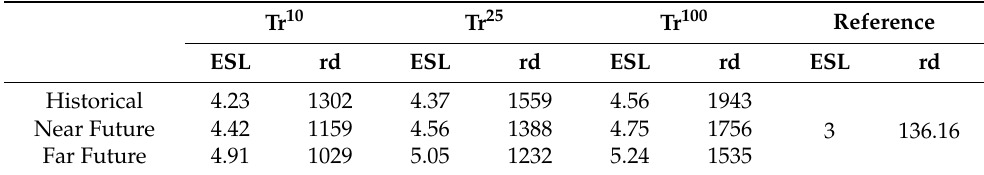
Table 9. Scenario definition. Extreme sea levels (ESL, m) and riverine discharge for Vouga (rd, m 3 /s) for the 10-, 25-, and 100-year return periods for the reference scenario (referred to present